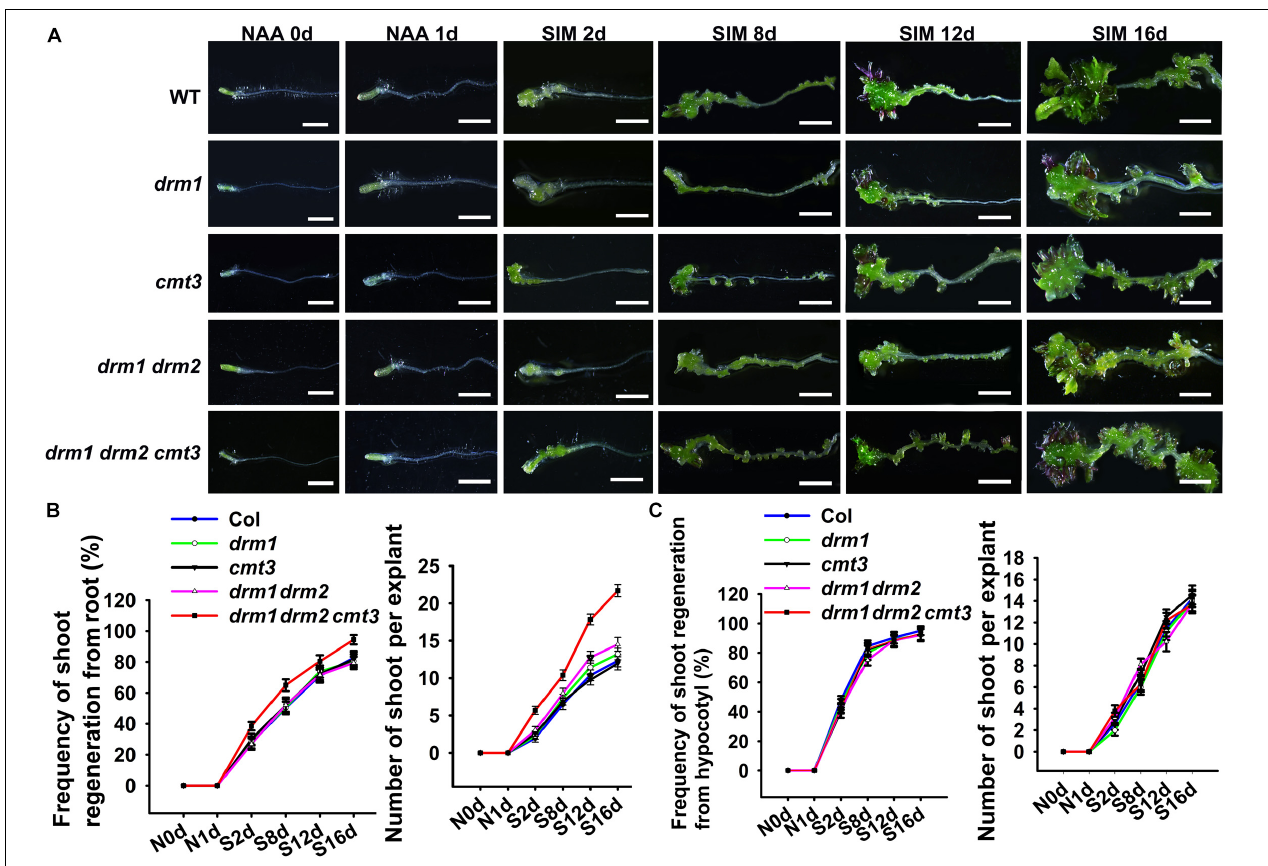
FIGURE 6 | Comparisons of shoot regeneration capacity between the ddc triple mutant and the wild type. (A) Shoot regeneration of drm1 , cmt3 , drm1 drm2, and ddc mutants. Days after NAA-treatment or SIM-culture are indicated in the bottom left corner of each panel. Frequency of shoot regeneration and number of regenerated shoots per explant are shown for direct (B) and indirect (C) regeneration systems. The frequency of direct regeneration was calculated as the shooted hypocotyl number/total hypocotyl number, while that of indirect regeneration was determined as the shooted root number/total root number. Error bars indicate the standard deviations of three biological replicates. For each replicate, more than 50 individual plants were used. Scale bars represent 10 µ